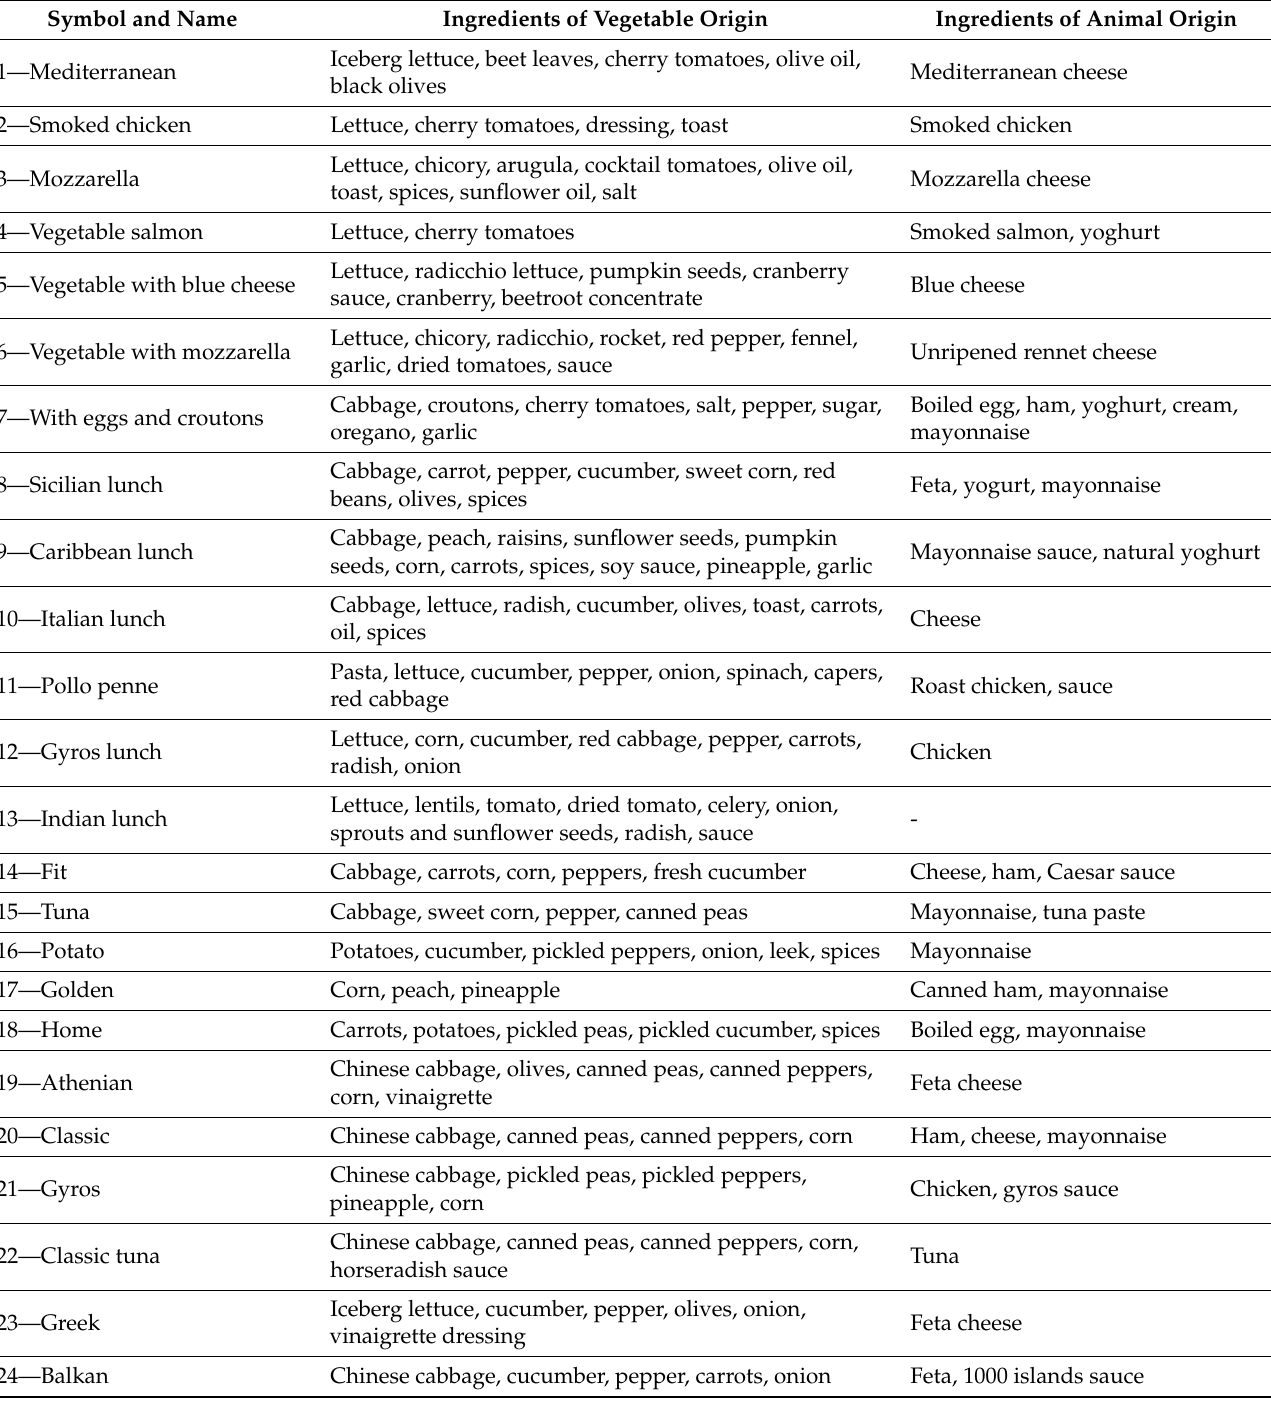
Table 1. Ingredients of the tested salads according to the producer’s